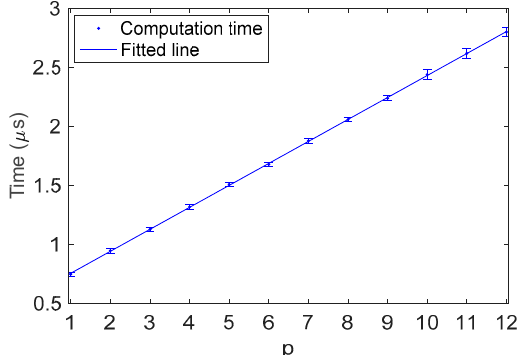
Figure 8. Computation time of the trajectory construction method.